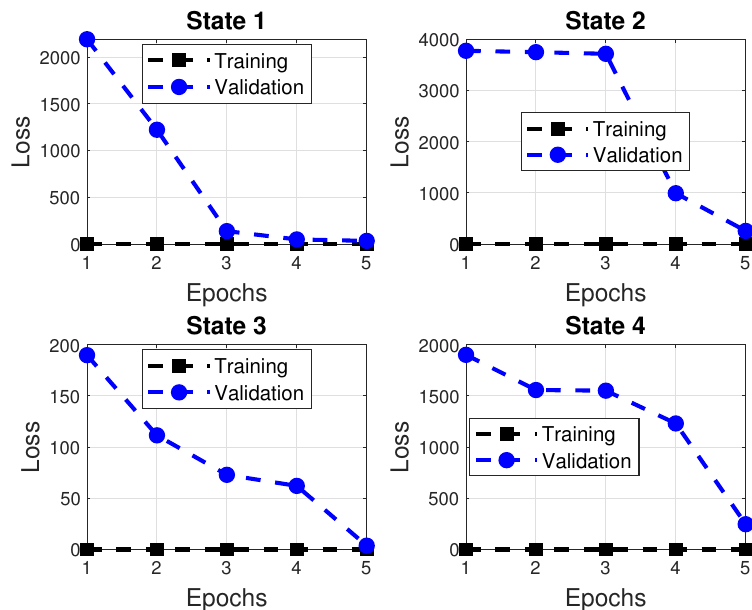
Figure 5. Training and validation MSE losses for Gradient